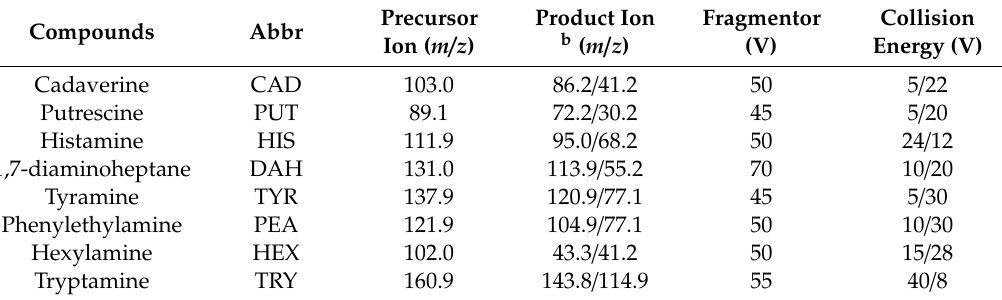
Table 1. MS parameters of seven BAs and the internal standard a